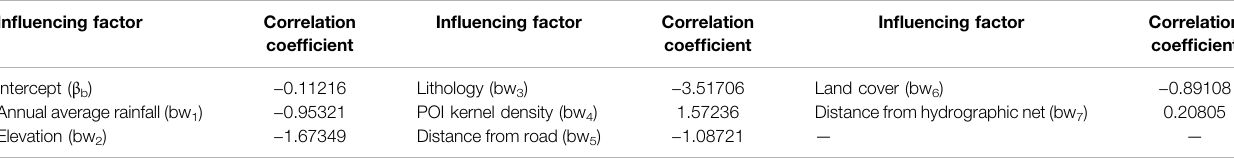
TABLE 5 | The correlation coef fi cients and function intercept values of LR bo .